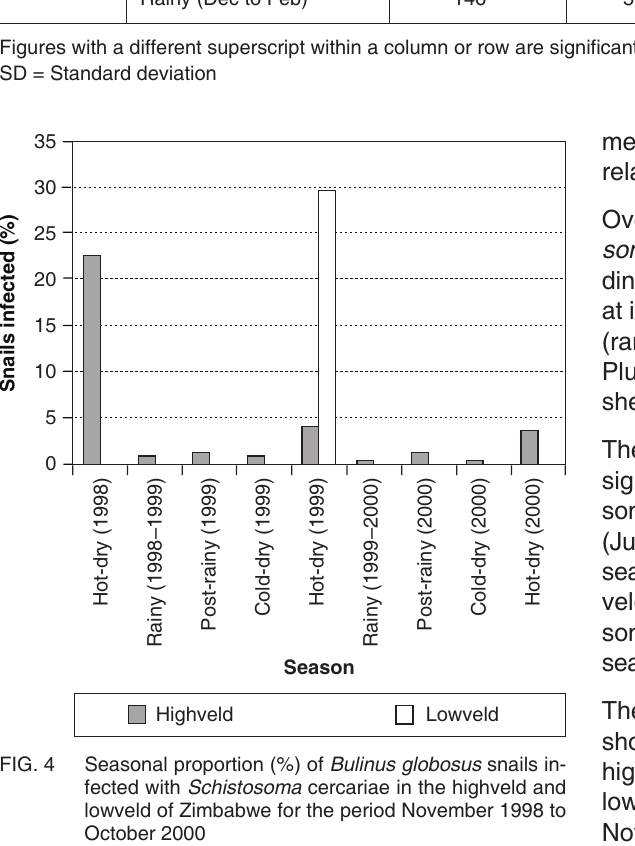
Figures with a different superscript within a column or row are significantly different at P < 0.05